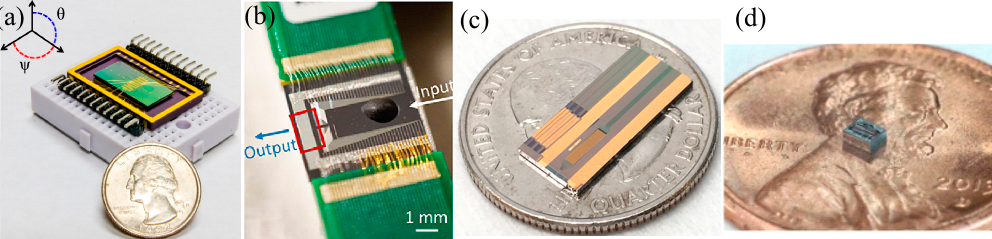
Figure 1. Integrated OPAs. ( a ) The wire-bonded device on the chip carrier plugged into the breadboard. Reprinted with permission from [40] © The Optical Society. ( b ) Blue light OPA. Reprinted with permission from [41] © The Optical Society. ( c ) A set of three 32-channel and one 240-channel OPAs on a coin. Reprinted with permission from the author of [42] published on Arxiv, 2018. ( d ) A photo of an OPA on a penny. Reprinted with permission from [43] © The Optical Society.